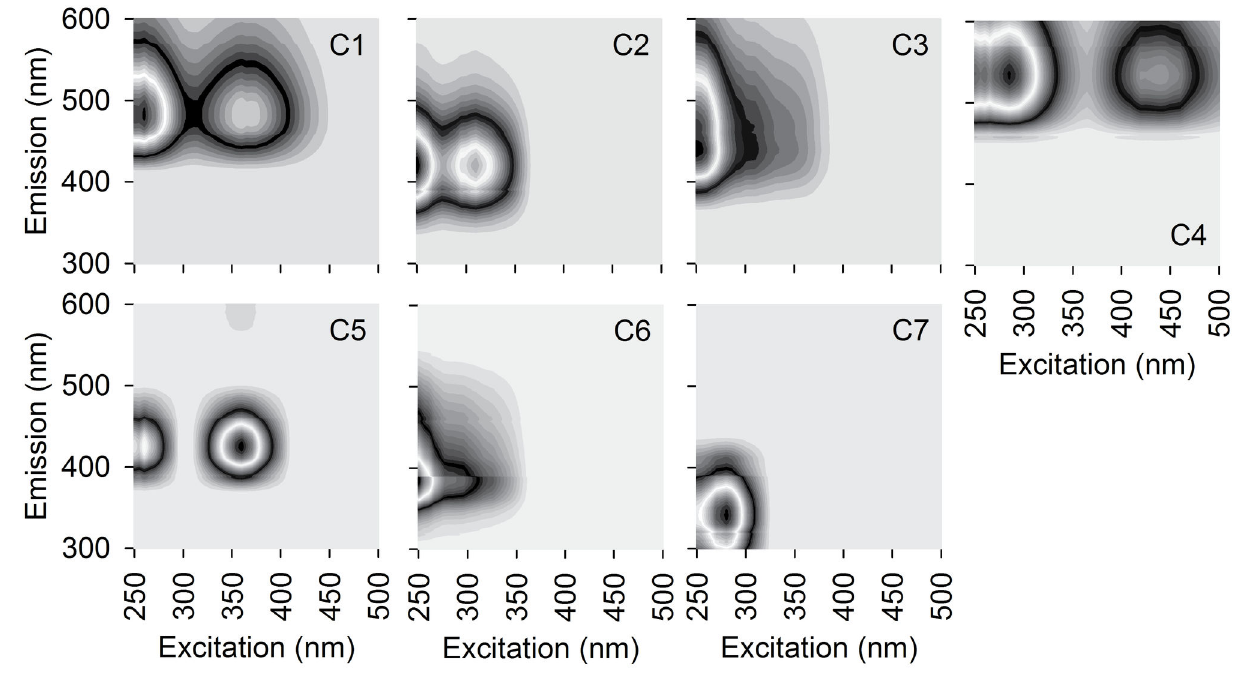
Figure 1. Countor plots of seven component PARAFAC